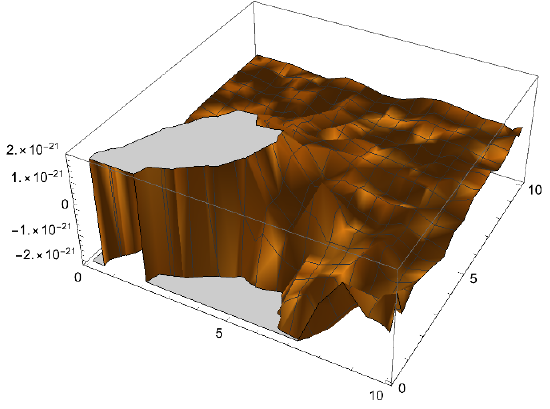
Figure 2 . Behaviour in the range 0 : 1 (cid:20) (cid:26) (cid:20) 10 ; 0 : 1 (cid:20) v (cid:20)